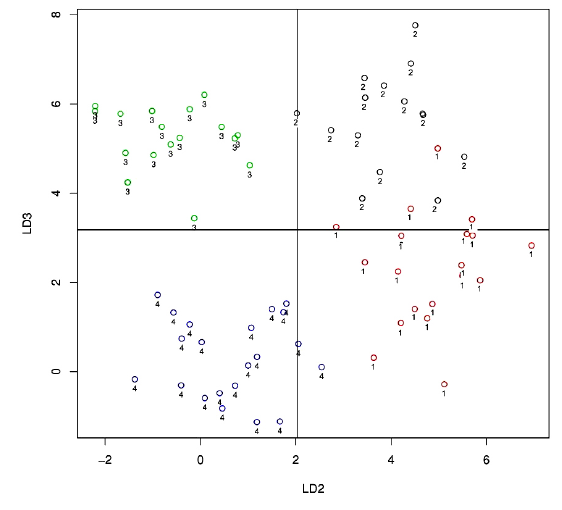
Fig. 4 . Scatterplot of second and third linear discriminant projections. 1 = Foreste Casentinesi, Monte Falterona e Campigna National Park (FCNP), 2 = Abruzzo, Lazio e Molise National Park (ALNP), 3 = Pollino National Park (PNP), and 4 = Aspromonte National Park